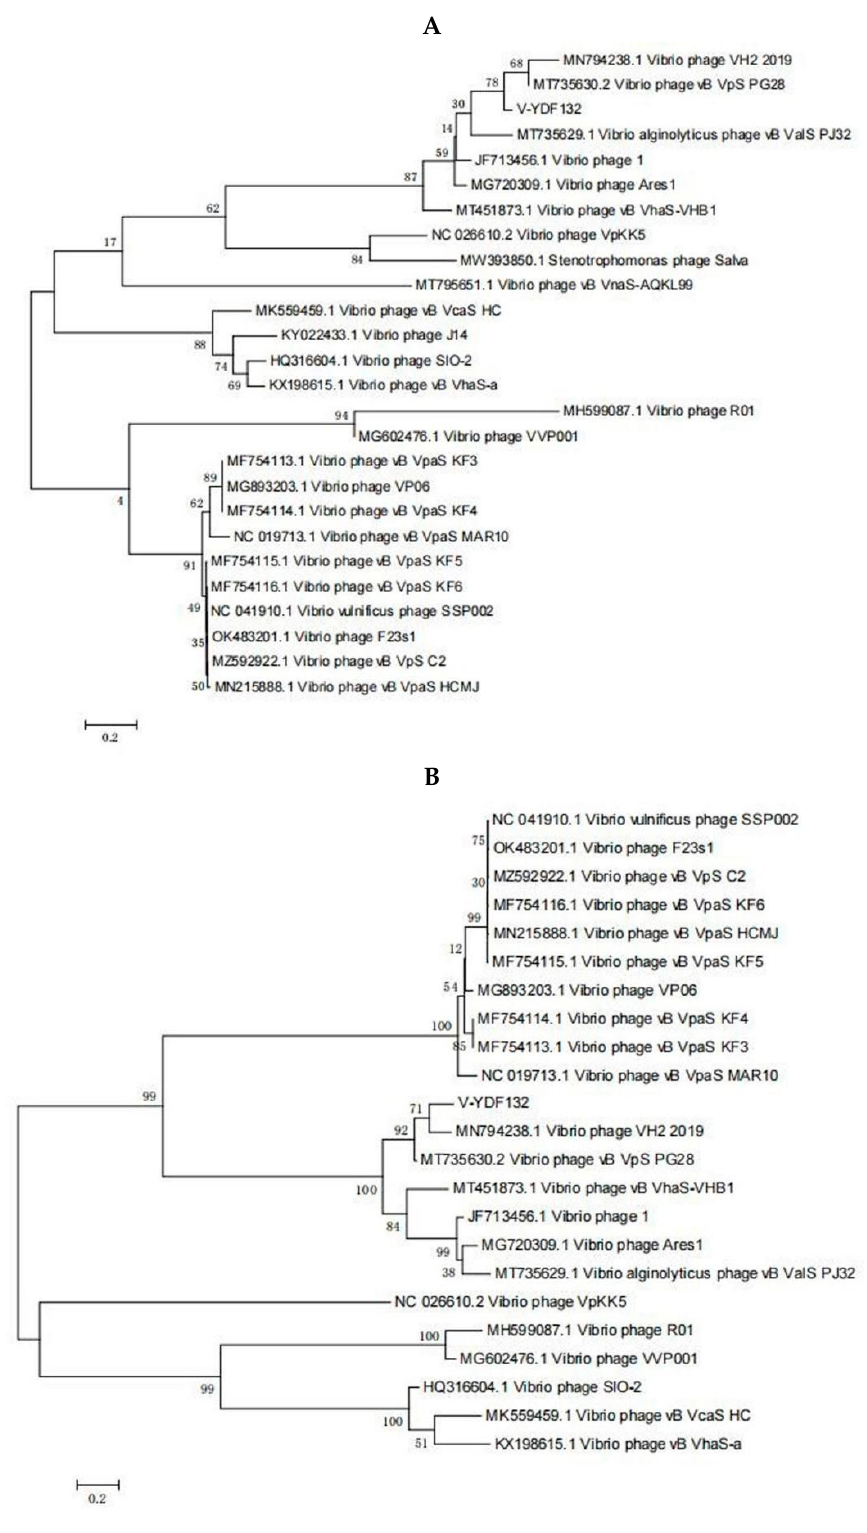
Figure 5. Phylogenetic tree showing V-YDF132 and other related phages of the Siphoviridae family and the Caudovirales order. The amino acid sequences of ( A ) the major capsid protein and ( B ) the terminase large subunit of the related phages were downloaded from the NCBI website.